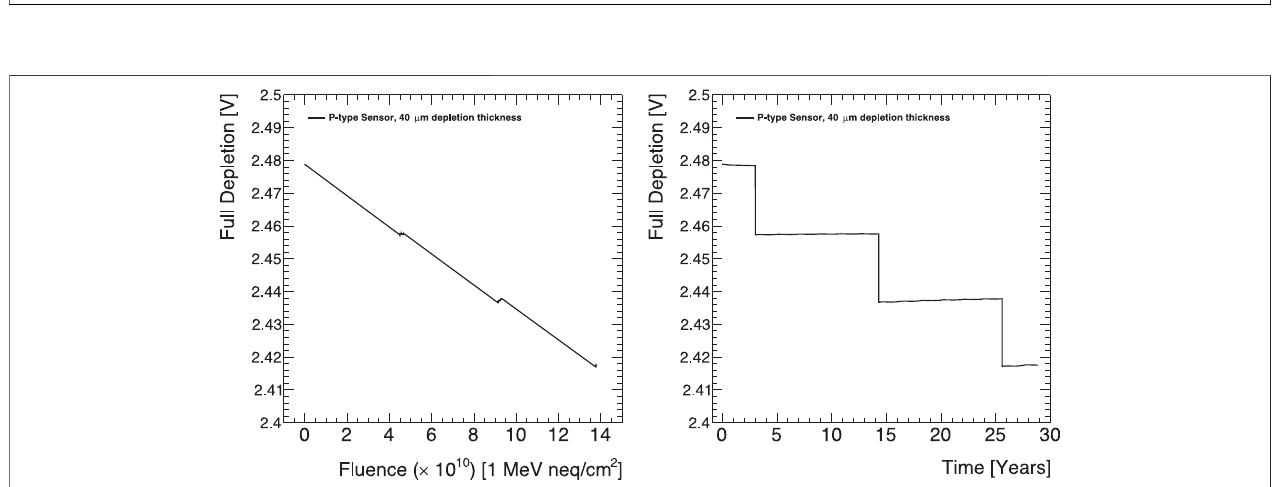
FIGURE 5 | Depletion voltage as a function of (left) integrated charged particle fl uence, and (right) time in Earth-years, for an oxygenated n-type silicon sensor of depletion depth 250 μ m.